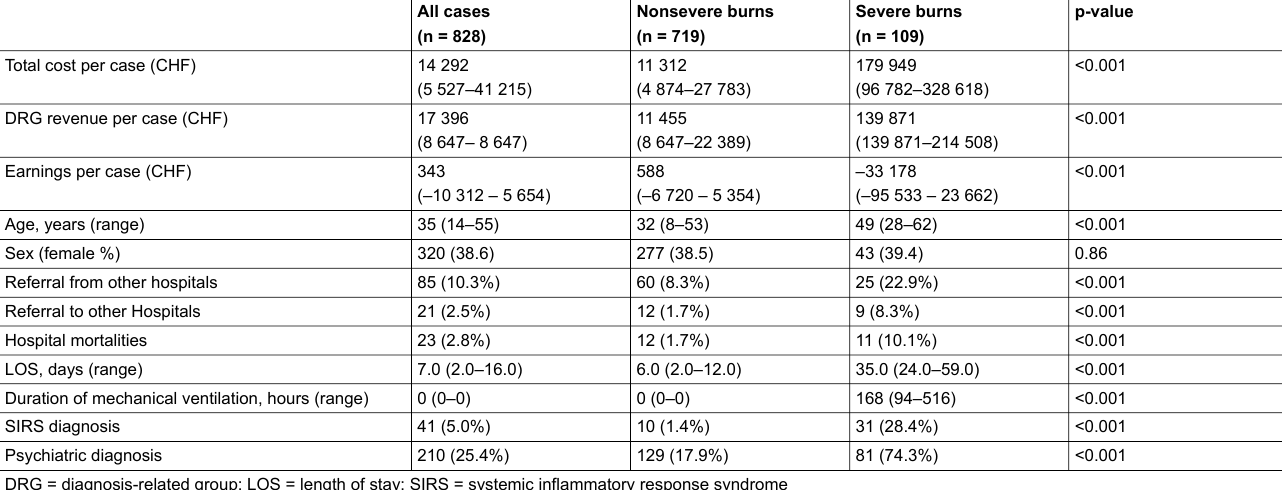
Table 1: Descriptive statistics of the study population: all discharges with coded burns diagnoses from any of the five Swiss university hospitals (n =